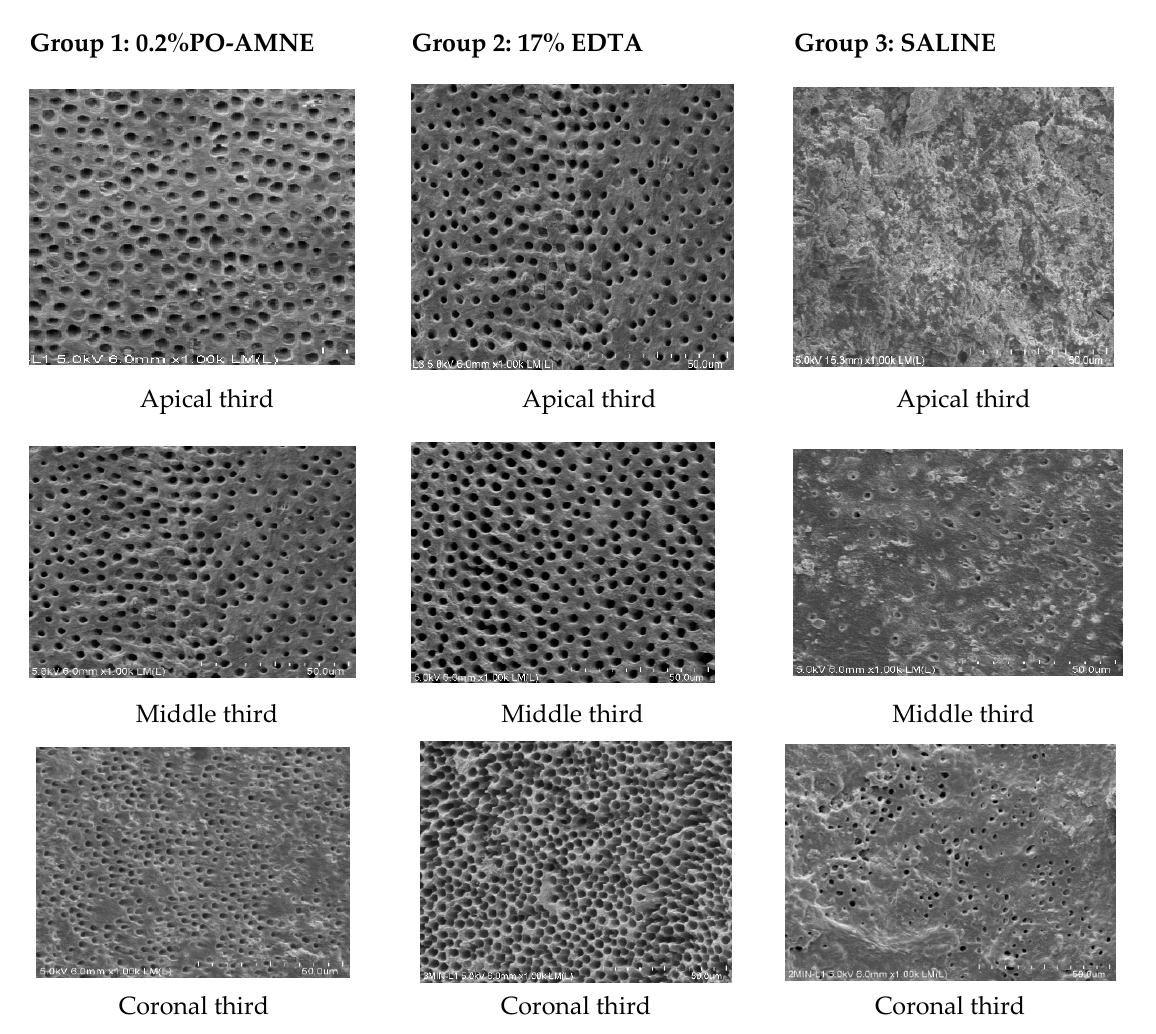
Figure 6. SEM images of all groups.